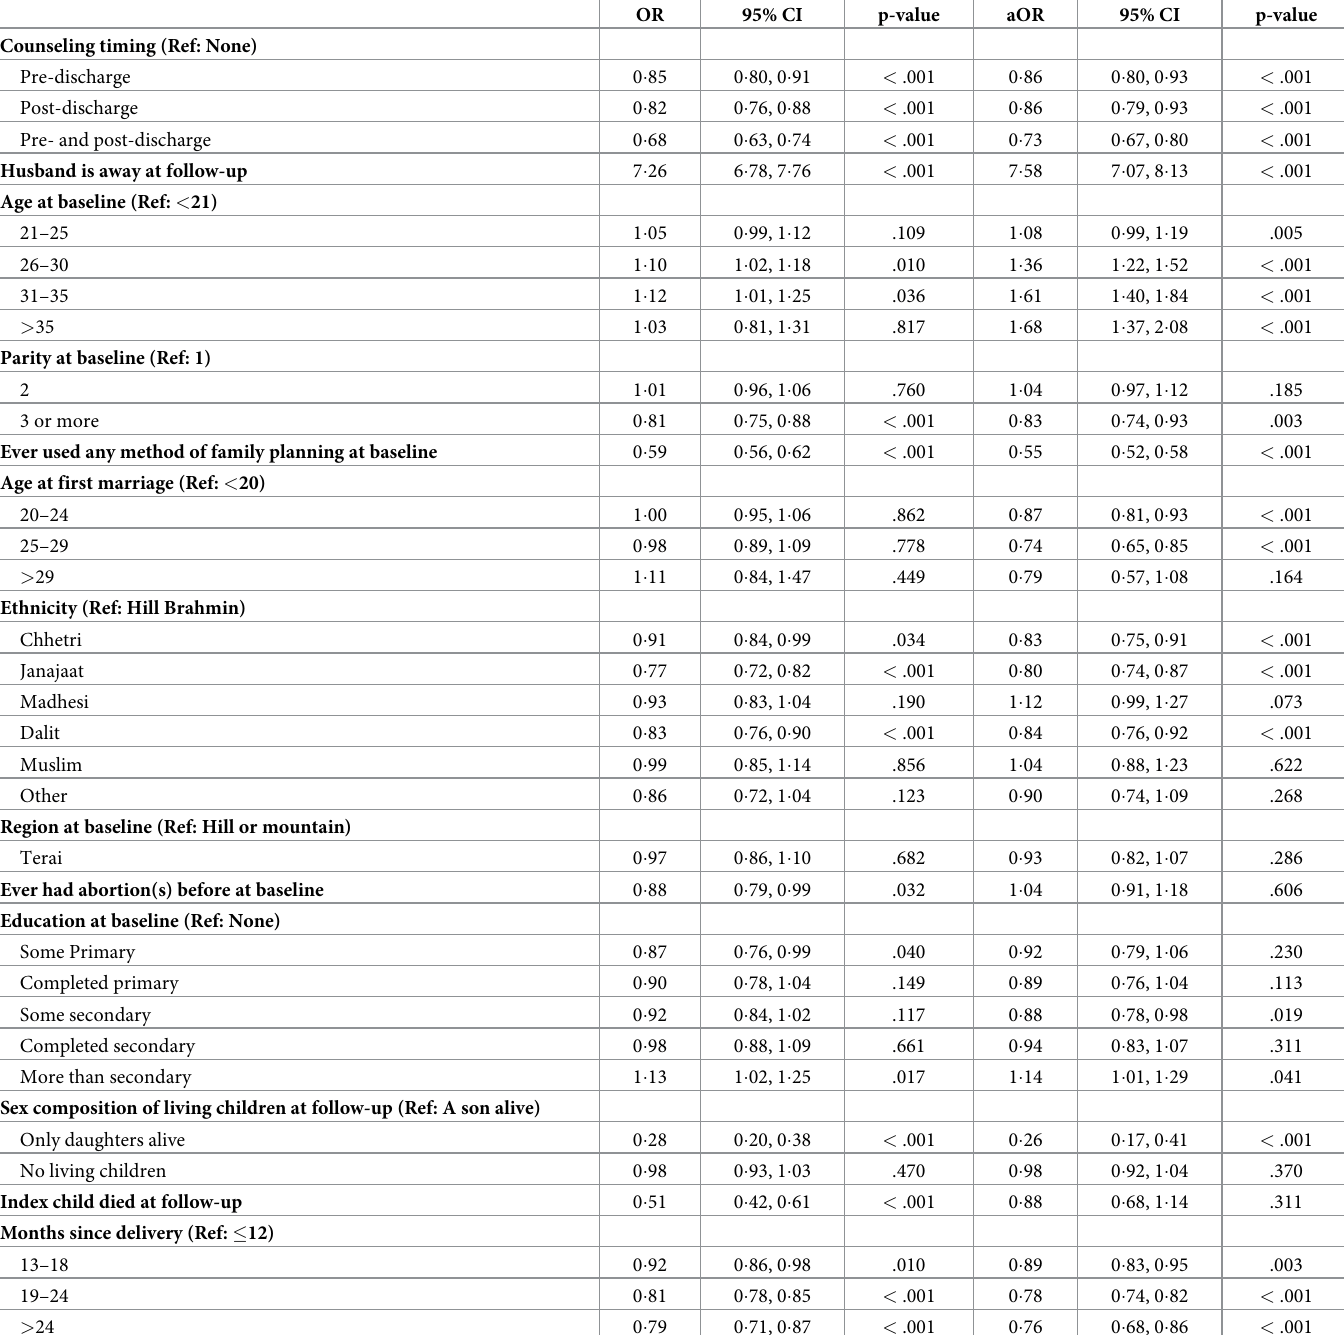
Table 4. Odds ratios of unmet need for modern contraception by counseling timing and women’s sociodemographic characteristics, in the postpartum period (N = 21280 women; N = 35613